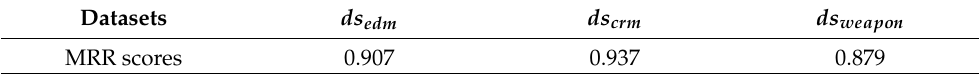
Table 3. MRR of semantic